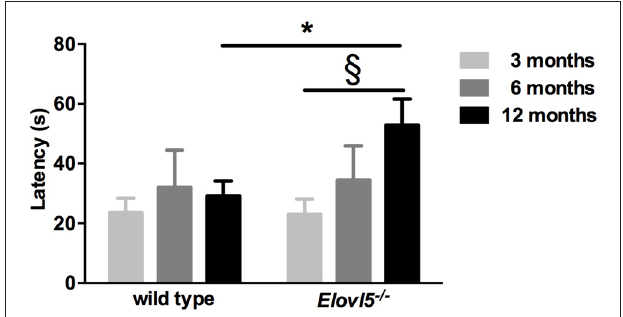
FIGURE 3 | Elovl5 − / − mice show hyposmia. The latency to find the buried cookie is significantly longer for Elovl5 − / − mice compared to wild type animals at 12 months (black bars; ∗ p < 0.05, t -test). At younger ages, no significant difference between genotypes was present ( p > 0.05, t -test). ∗ Comparison between genotypes; (§) comparison between 3 and 12 months of the same genotype. Values are mean ±